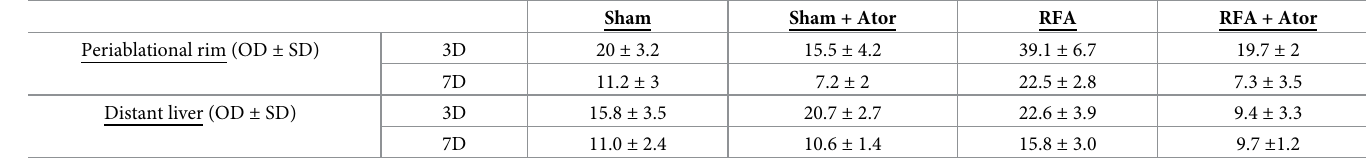
Table 1. Effect of myofibroblast blockade on Hepatocyte growth factor upregulation in the periablational rim and distant liver post-RFA.